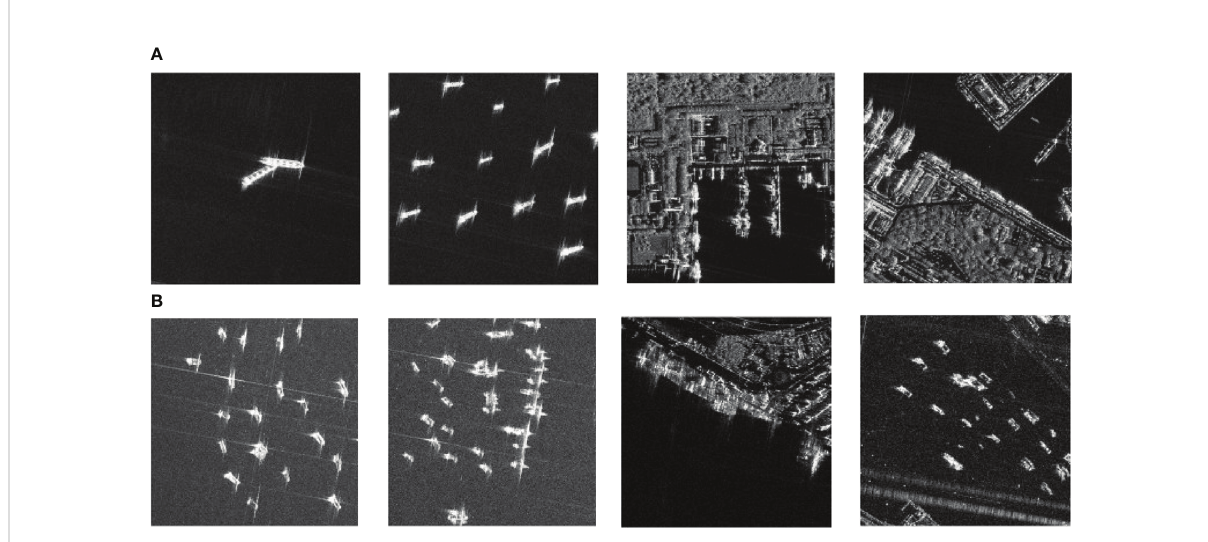
FIGURE 8 Inshore, offshore and different scale ship target on SAR images, (A) ships from the fi rst SAR large scene images presented in Figure 13A, and (B) ship from the second SAR large images presented in Figure 13B.